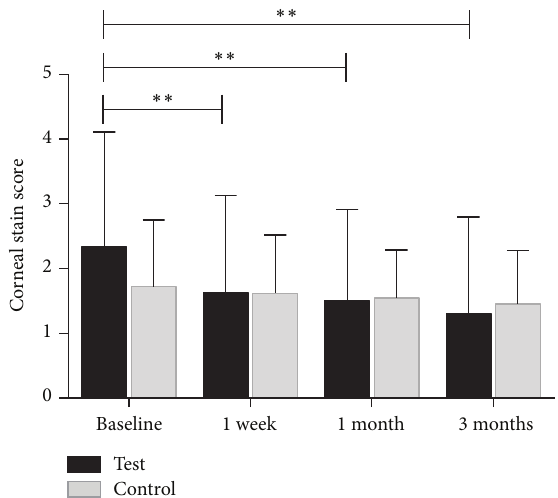
Figure6:Themeanvalueoftest-eyecorneastainingscoremeasured at baseline, at one week, at one month, and at three months ( ∗ 𝑝 < 0.05 , ∗∗ 𝑝 < 0.001 ).